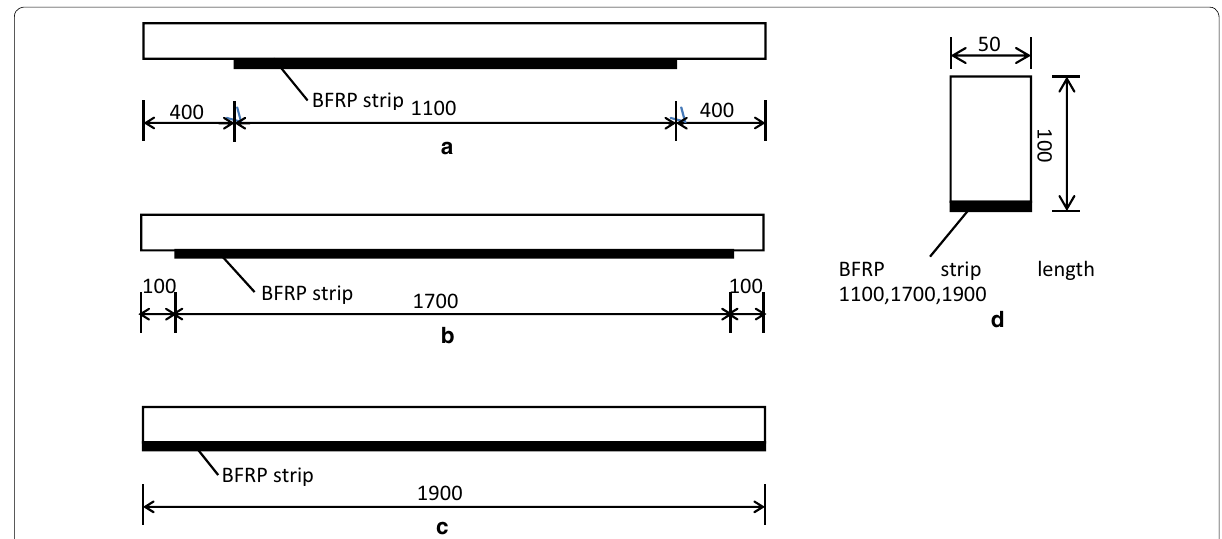
Fig. 3 Details of strengthening configurations: a JGL(B50-1100)-01&02; b JGL(B50-1700)-01&02; c JGL(B50-1900)-01&02; d cross-sections of all strengthened beam (unit: mm)